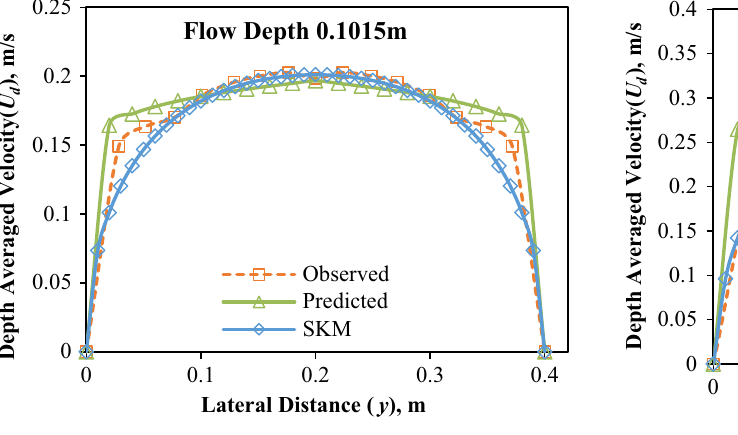
Fig. 13 Depth-averaged velocity of FCF,UK channel series